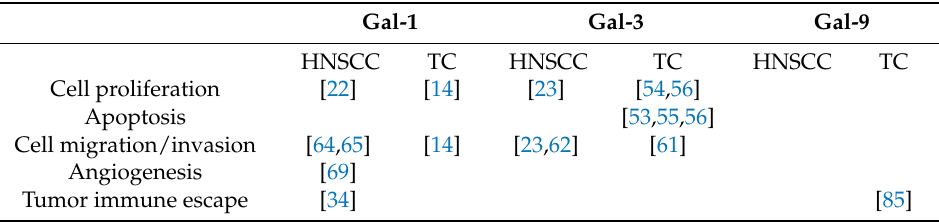
Table 2. Main references supporting a role for galectins in head and neck and thyroid cancer cell proliferation, migration/invasion, angiogenesis, and tumor immune